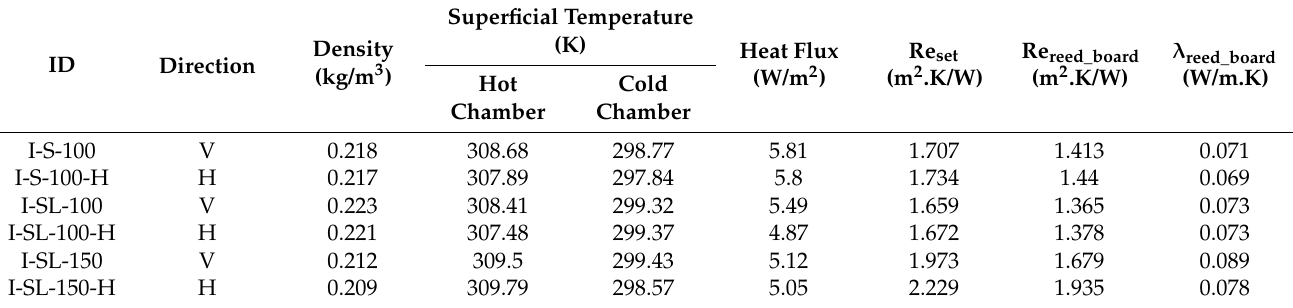
Figure 10. Boards with giant reeds in different directions: ( a ) vertical direction; ( b ) horizontal direction. Table 7. Average values of the studied thermal parameters considering different directions during the hotbox